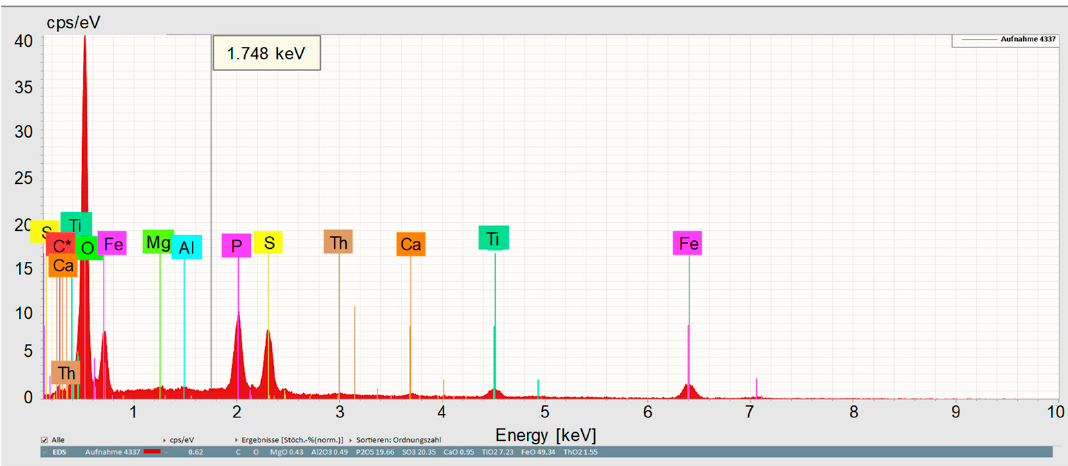
Figure 19. Backscattered electron image of the delicate flakes found in the residue.